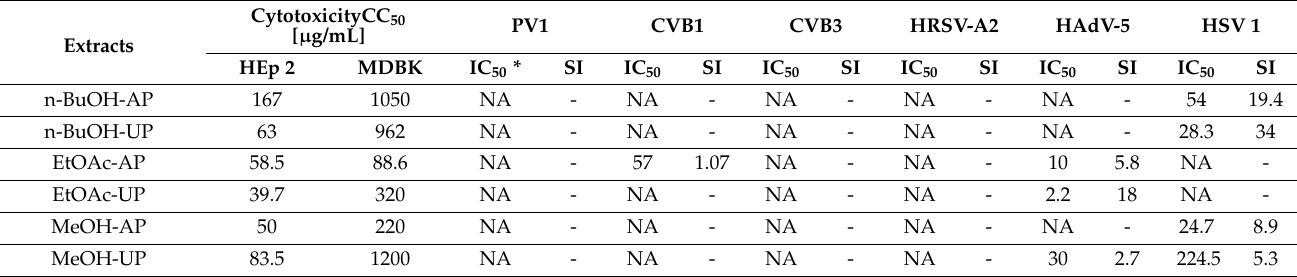
Table 4. Antiviral activity of six Geum urbanum